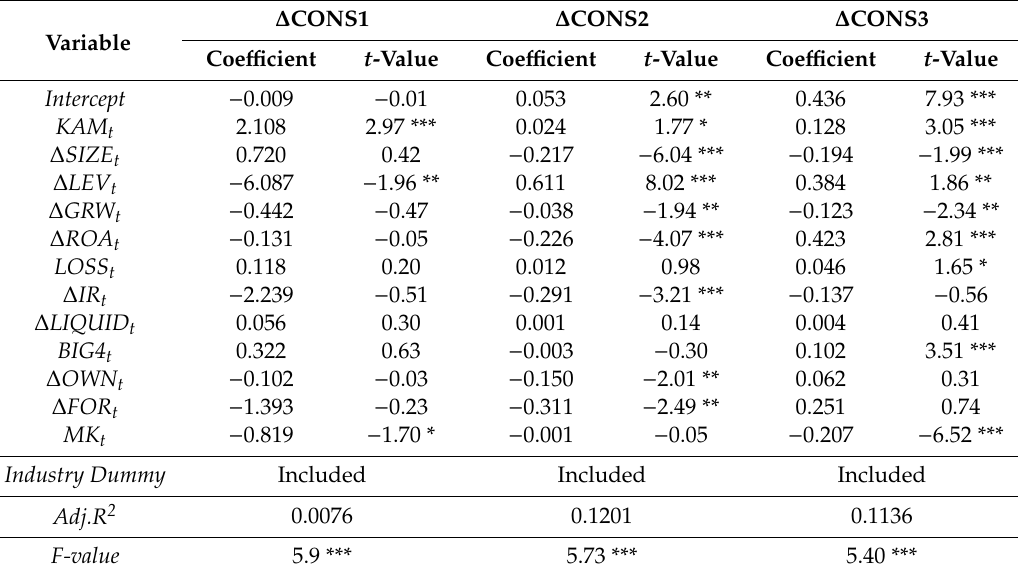
Table 6. The E ff ects of KAM on Conservatism Using Change in Variables ( n =